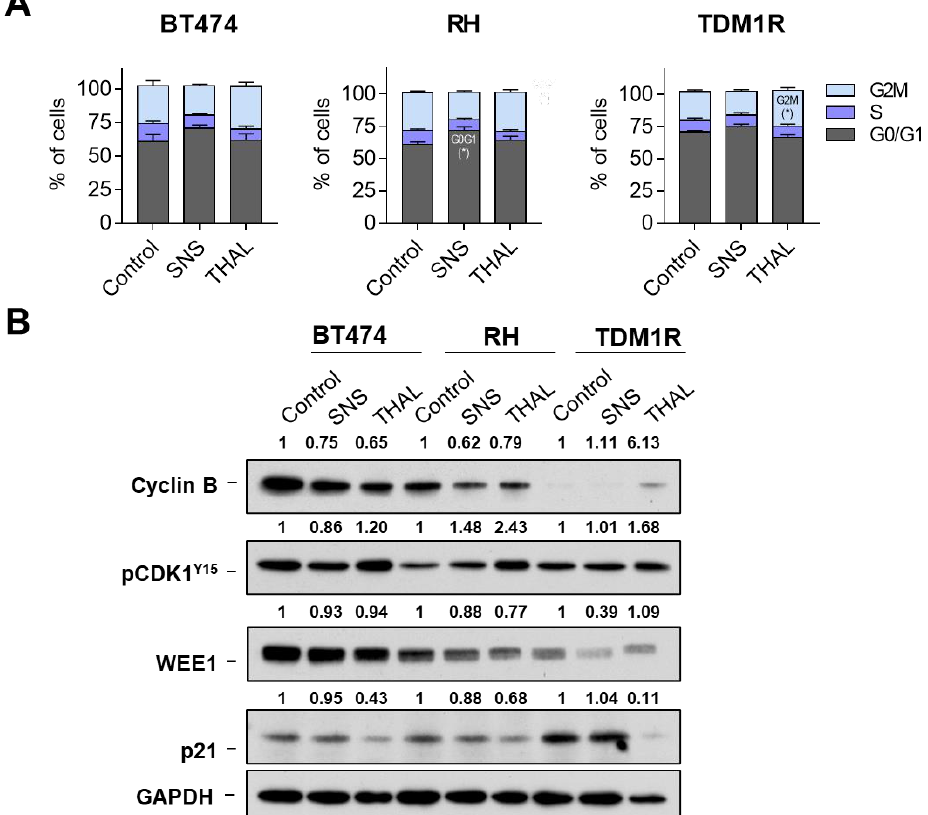
Figure 4. Cell cycle analyses of SNS-032 and THAL-SNS-032 in BT474 and BT474-derived cell lines representative of adaptive resistance. Bar graph showing populations generated by flow cytometry in each phase of cell cycle for BT474, RH, and TDM1R cells of SNS-032 (50 nM) and THAL-SNS-032 (50 nM) for 24 h ( A ). Expression of proteins involved in cell cycle in cell lines treated with SNS-032 (50 nM) and THAL-SNS-032 (50 nM) for 24 h. GAPDH was used as a loading control ( B ). * p <